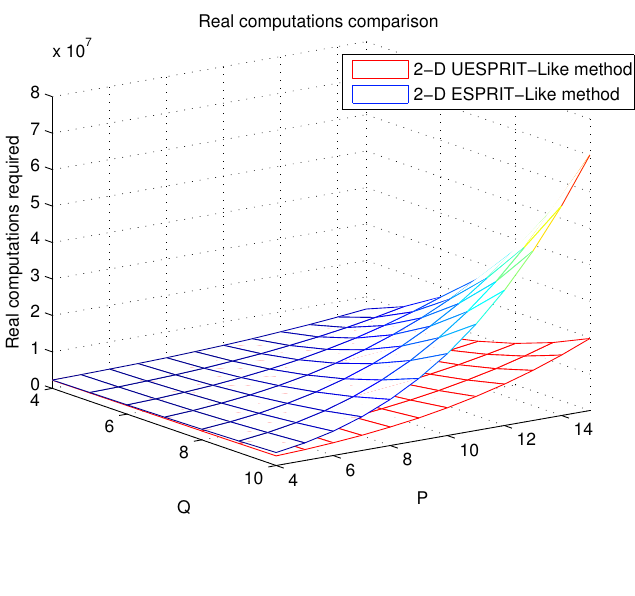
Figure 2. Real computations needed to estimate the 2-D DOA as a function of P and